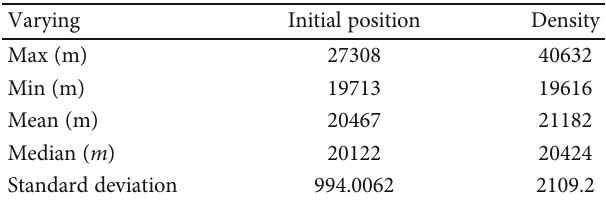
Table 11: Statistics of norm of fi nal missed distance for Monte Carlo simulation in the Mars model.